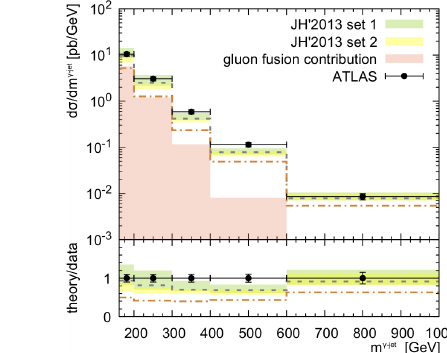
y γ + y jet < 2 . 37 are applied. Notation of histograms | |